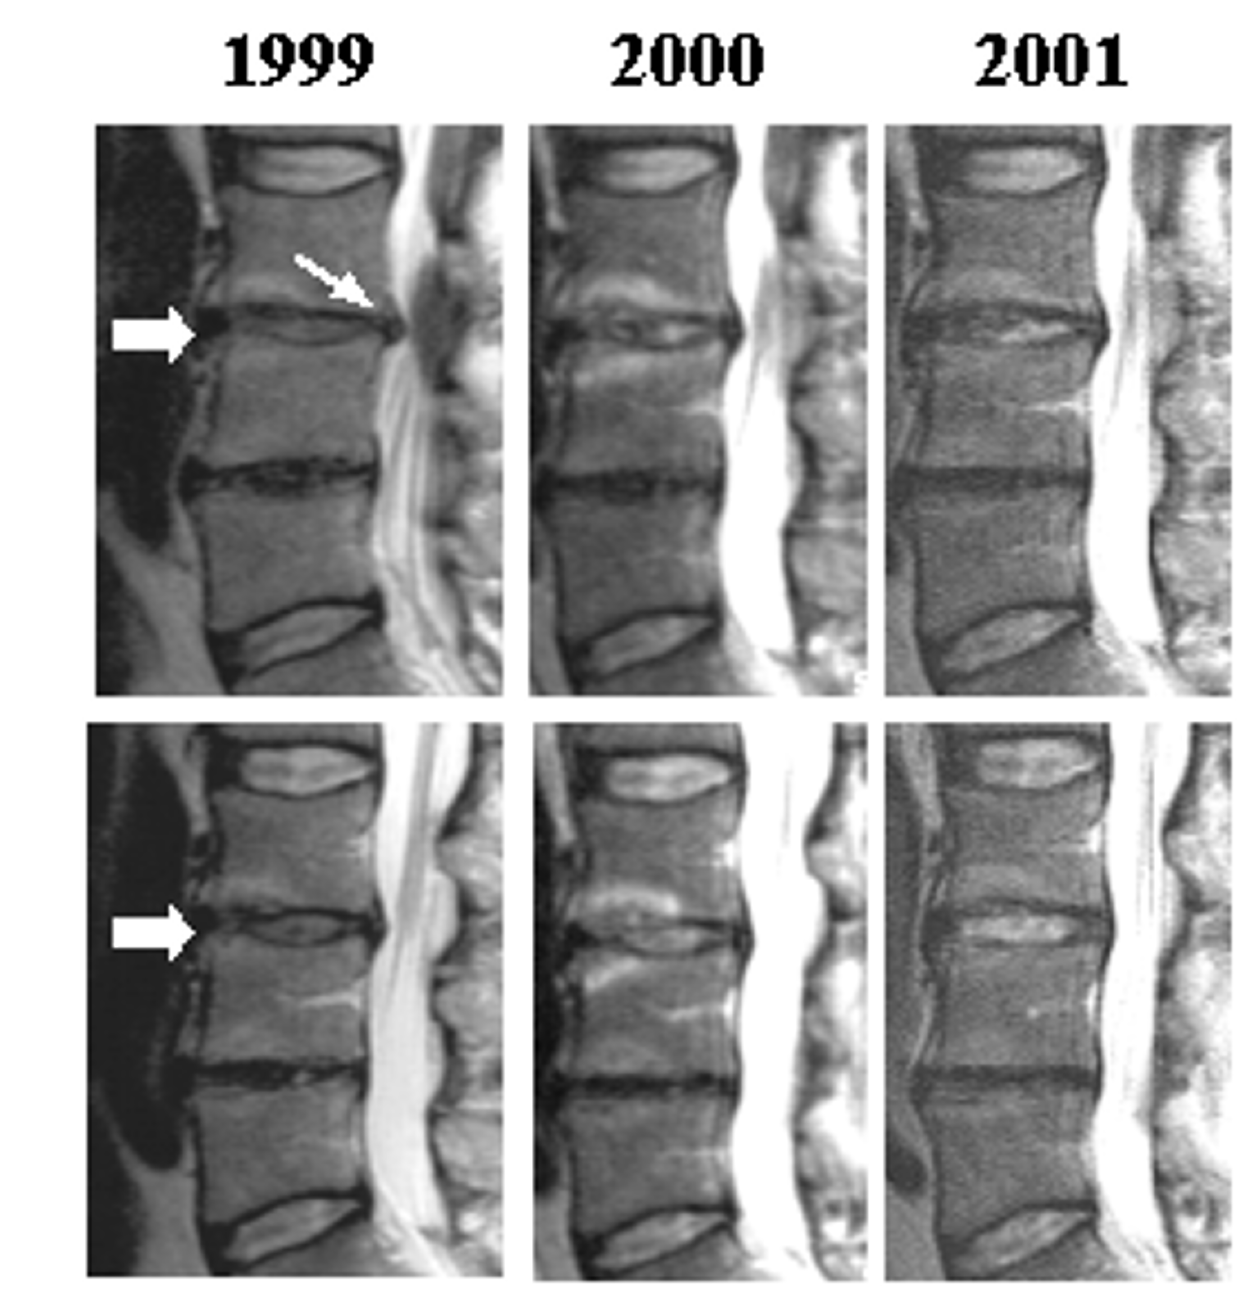
Disc cartilage regeneration during 2 years of supplement intake . T2-weighted MR images of lumbar spine, made in September 1999 (start of supplement intake), 2000 and 2001. Note the increase of MRI signal of disc L3-4 (thick arrows) and disappearance of focal disc protrusion (thin arrow) of this disc. Note that the fully degenerated L4-5 disc remains unchanged. Upper panels and lower panels represent two consecutive images of planes 4 mm